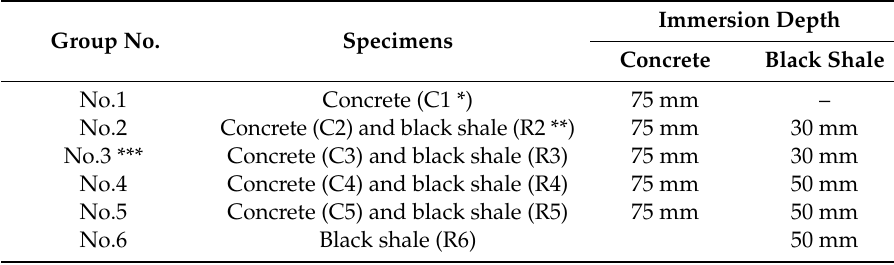
Immersion Depth Concrete Black Shale